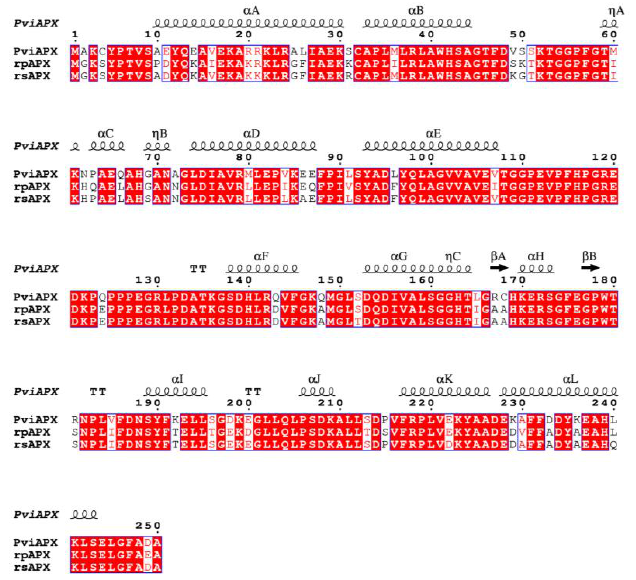
Figure 3. Sequence alignment of ascorbate peroxidases in monocots and dicots. Switchgrass APX (wild-type) was aligned with pea cytosolic APX (rpAPX) and soybean cytosolic APX (rsAPX). The secondary structure numbering followed the convention of peroxidase structure [40]. α refers to α - helices, β to β - strands, π to π - helices and η to 3 10 -helices. The conserved areas are enclosed in a blue frame. Red shaded, red characters and blue frames indicate descending similarity scores calculated with ESPript 3.0. This figure was generated using ESPript 3.0 (https://espript.ibcp.fr/ESPript/cgi- bin/ESPript.cgi accessed on 20 November 2022) [41]. Table 1. Crystallography statistics of PviAPX.